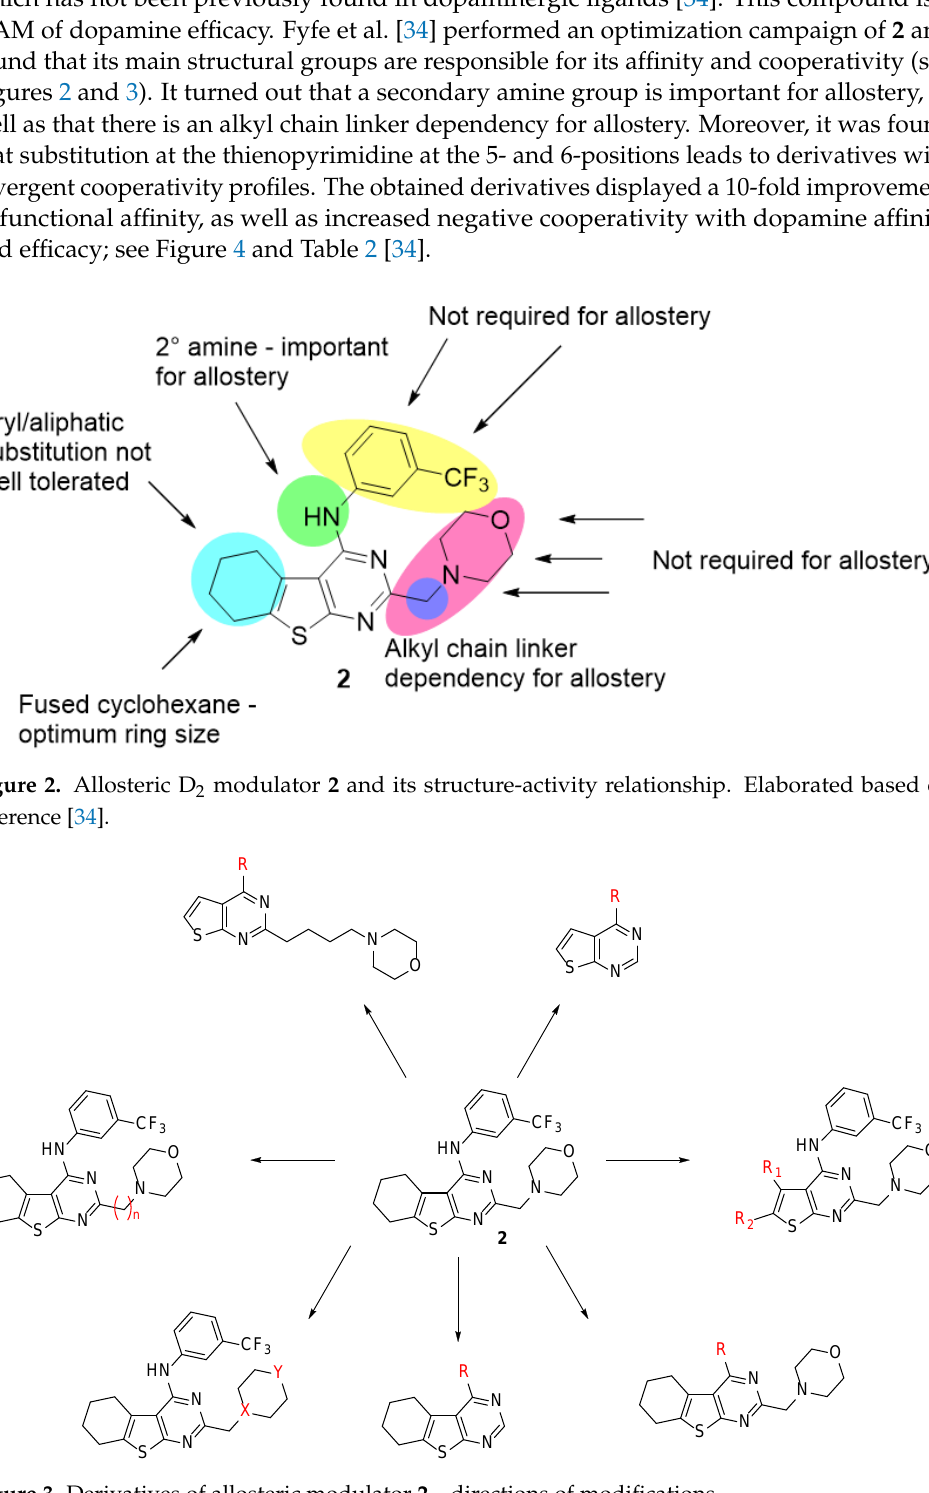
N N HN 2e Figure 4. Derivatives of allosteric modulator 2 . In the subsequent work , the same research group showed that subtle modifications to a thieno[2,3-d]pyrimidine scaffold yield negative allosteric modulators of D 2 receptor [35]. They obtained NAMs with divergent affinity/cooperativity profiles (see Figure 4 and Table 2). First, they evaluated the effect of the type of amine substituent at the 4-position in the 5,6,7,8-tetrahydrobenzo[4,5]thieno[2,3-d]pyrimidine scaffold. Next, they studied various substituents at the 5/6-fused cyclohexane moiety, together with the most favorable amine types at the 4-position. As a result of another HTS campaign carried out at UCB Biopharma, a positive allo- steric modulator of D 2 receptor 3 , see Figure 5 was identified [36]. It was a benzothiazole derivative and in its racemic form, it behaves as a PAM of D 2 receptor. The R enantiomer potentiates the effects of dopamine while the S enantiomer attenuates the effects of the PAM and the effects of dopamine. The effect of enantiomers of compound 3 on the satura- tion binding of [ 3 H]-dopamine to the human dopamine D 2 receptor is shown in Table 3. Żuk et al. [37] performed molecular dynamics simulations, which confirmed that the R enantiomer of compound 3 is a PAM of the D 2L receptor, while its S enantiomer is a NAM. Moreover, the authors obtained a derivative of compound 3 , compound 3a (see Figure 5) as a racemic mixture and based on the principal component analysis (PCA), they hypothe- sized that both enantiomers of compound 3a behave as silent allosteric modulators, which